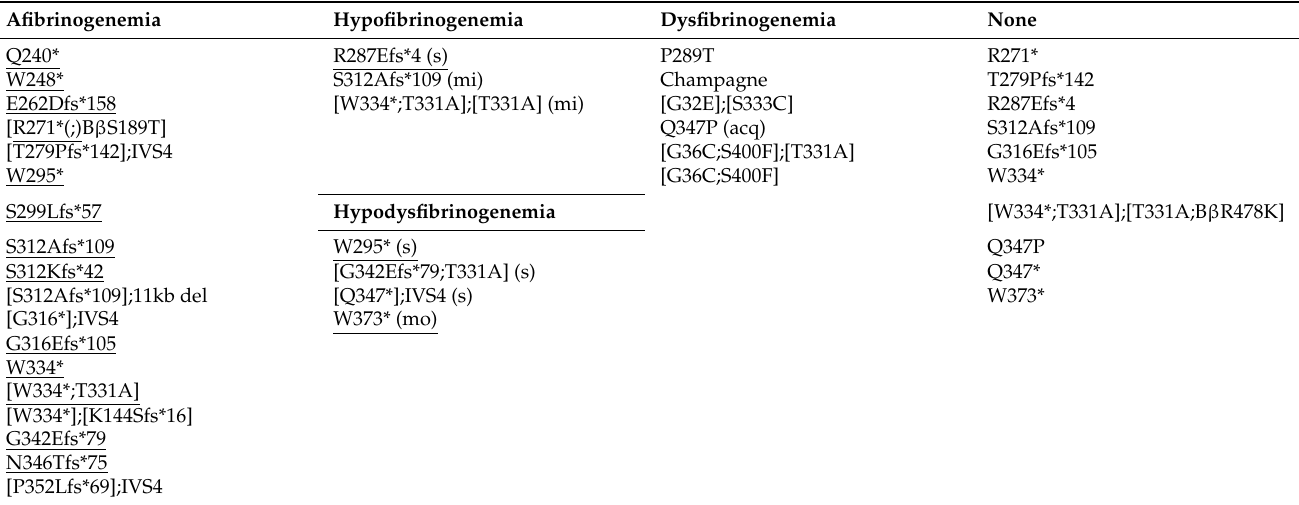
Table 2. Mutations in the α C-connector of fibrinogen assigned to the CFDs they cause. The posi- tions within the nascent protein chain are used. Homozygous mutations are underlined. Cham- pagne = complex fibrinogen Champagne au Mont d’Or; IVS4 = intronic mutation g.510+1G>T; 11 kb del = RCV000017876.28; s, acq = acquired, mo, and mi = severe, moderate, and mild hypofibrinogene- mia and hypodysfibrinogenemia,